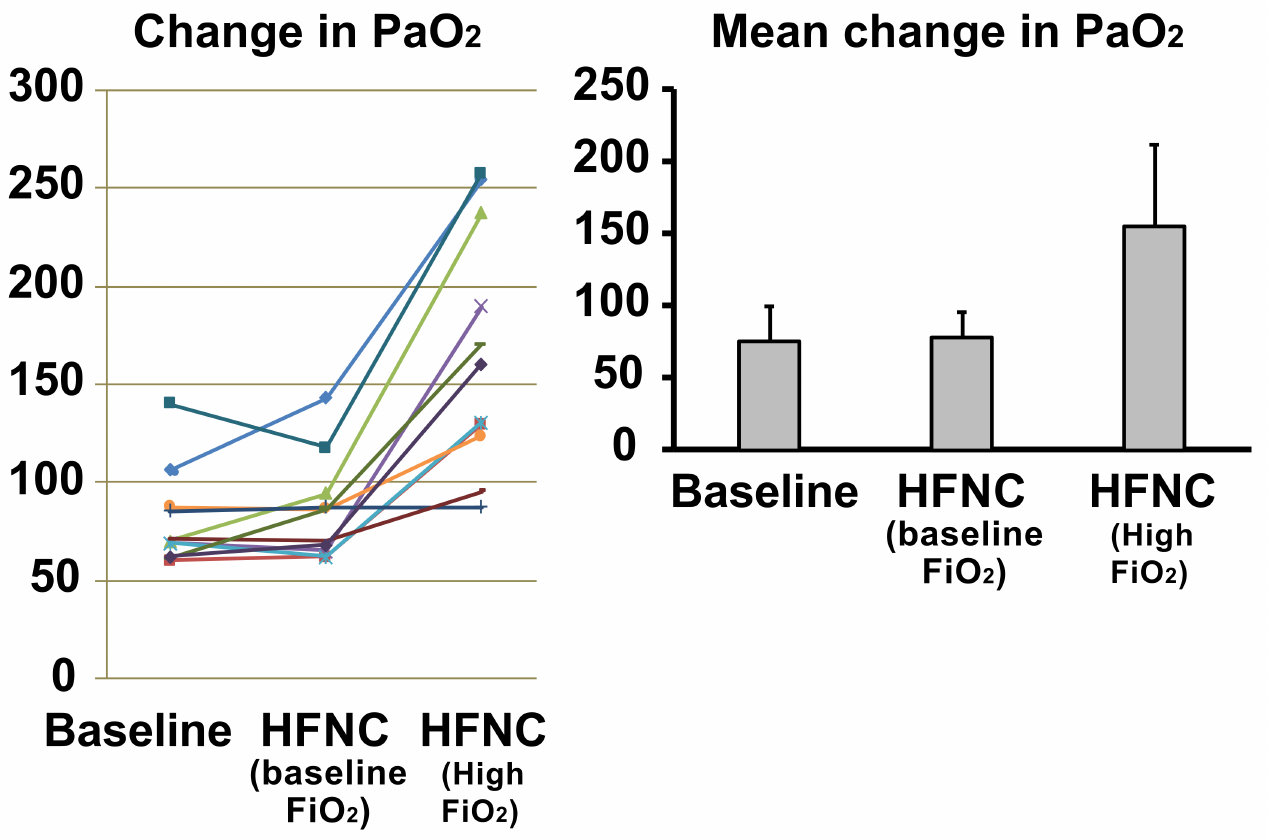
Figure 4. Response to increased oxygen delivery via high flow nasal cannula in COPD patients. The PaO 2 did not show a significant change ( p = 0.60) when HFNC was applied at baseline FiO 2 and increased significantly ( p < 0.001) when the FiO 2 was increased by 30%. Each colored line represents the individual response of the